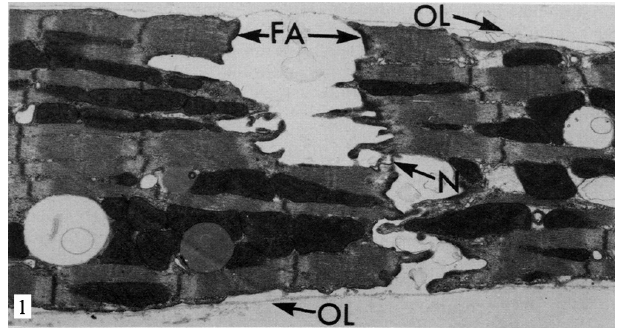
Fig. 1 - Electron micrograph of rat heart after 12 minutes of perfusion without calcium at 37 o C. The intercalated disks are separated in the regions of the fascia adherens (FA), but are still interconnected by the nexus joints (N). The outer layer of the sarcolemma (OL) or glycocalyx is detached from the plasma membrane of the